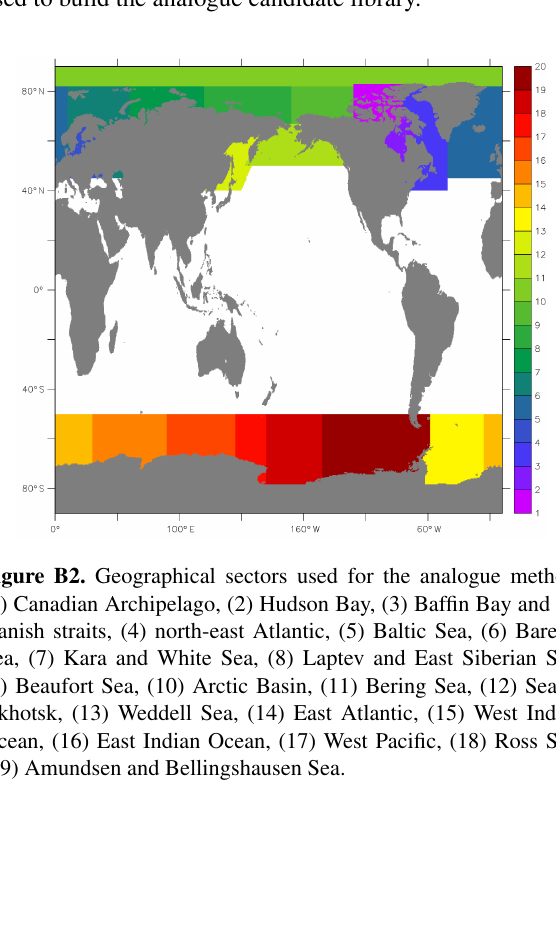
Table B1. CMIP5 AOGCMs used to build the analogue candidate list.